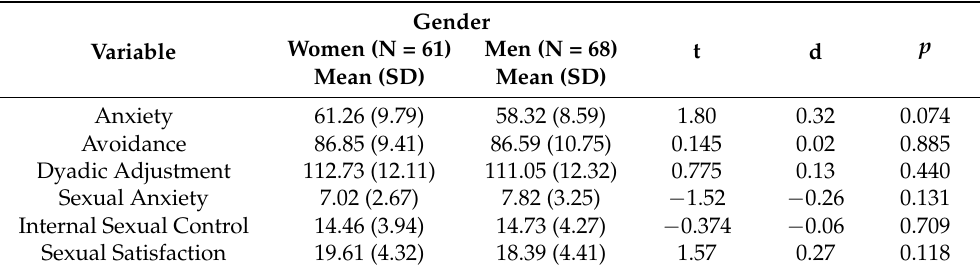
Table 4. Table of comparisons between infertile women and men for sexual, attachment, and adjust- ment dimensions.